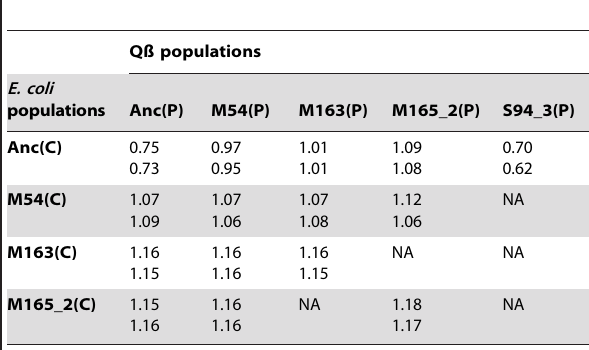
Table 1. Fitness of ancestral and evolved E. coli .